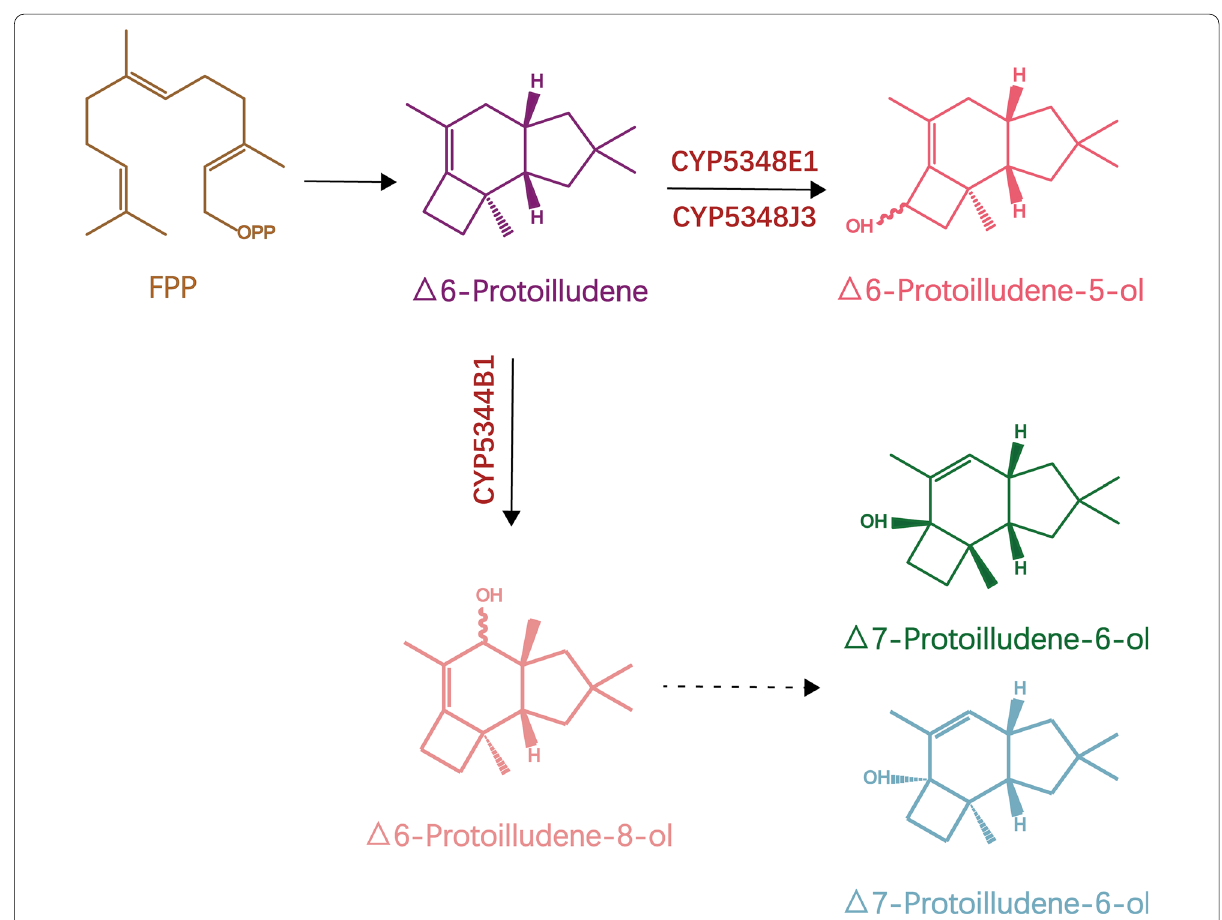
Fig. 3 Reaction pathways of protoilludene metabolism by PpSTS and PpCYPs